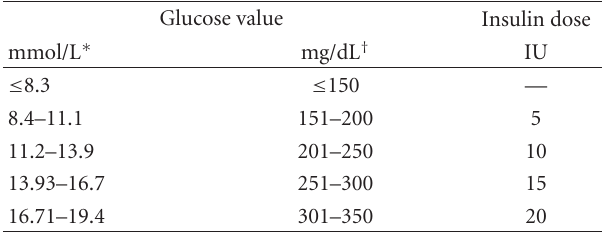
Table 5: Hypoglycemia management. Administer hypertonic dextrose (50%) according to the following formula: Check plasma glucose every 30 minutes Overcorrection will be avoided in all